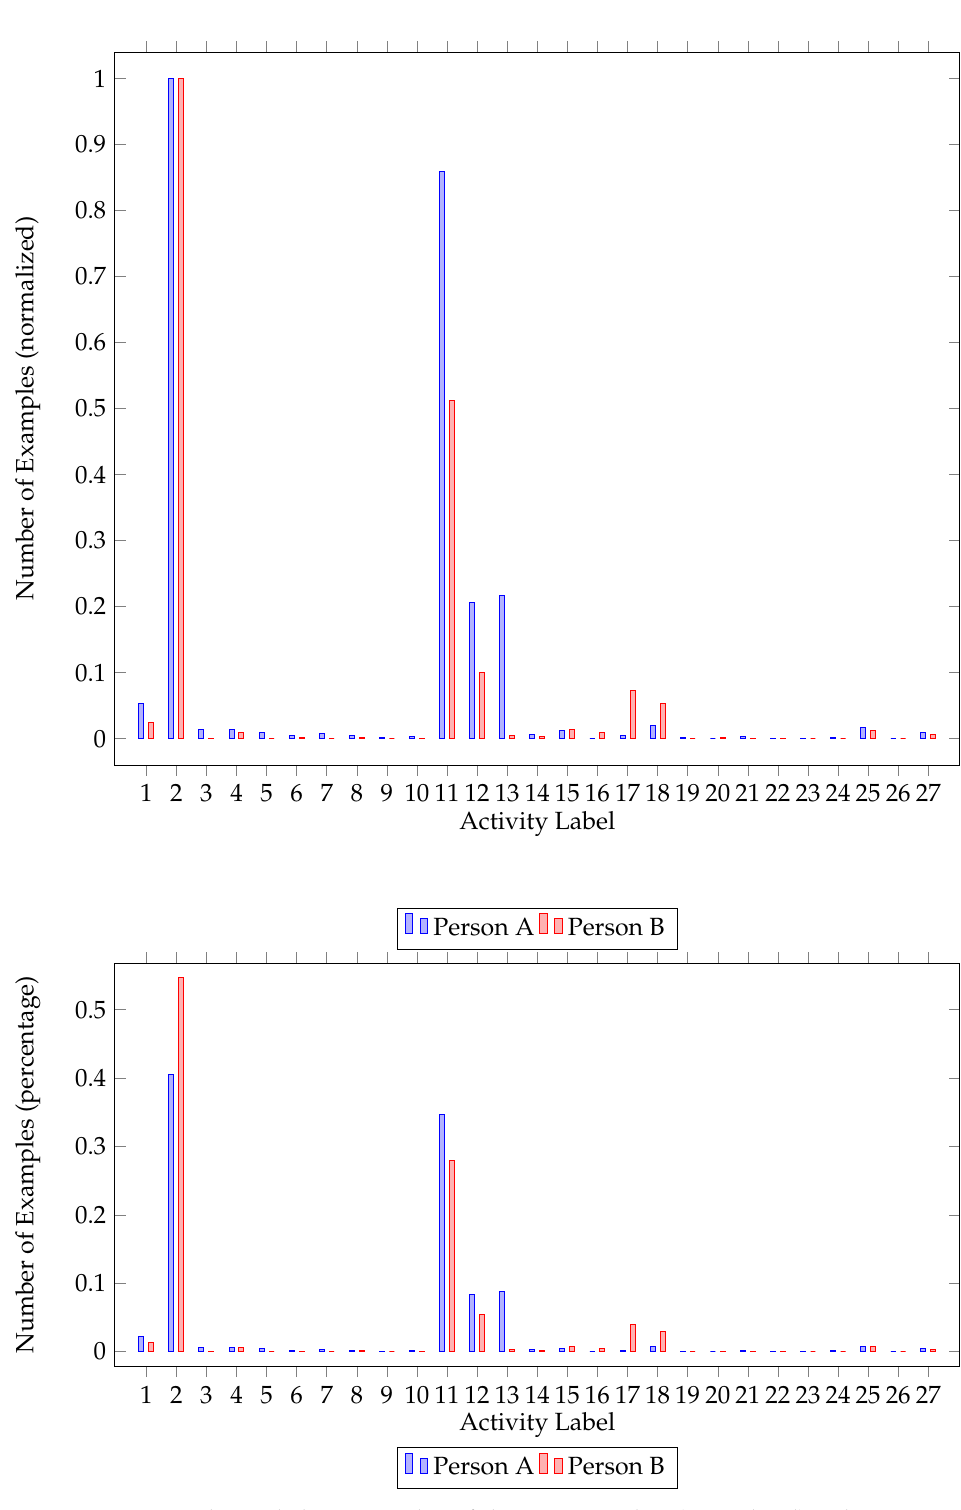
Figure 2. House B class imbalance. Number of classes per resident (normalized) and percentage of each class for the first